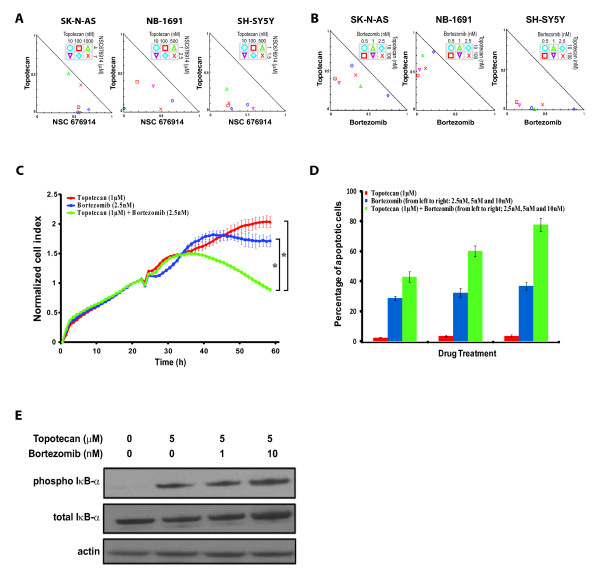
NF-κB pathway inhibitors potentiated topotecan-induced growth inhibition and caspase-3 activation in neuroblastoma cells. (A) Synergistic growth inhibition effect of topotecan and NSC 676914 in combination in three neuroblastoma cell lines (combination index <1). Sub-IC50 drug doses are used in combination and cell growth is plotted in the normalized isobolograms. (B) Normalized isobolograms showed synergy in growth inhibition by the combination of topotecan and bortezomib in three neuroblastoma cell lines. Shown is representative of three independent experiments. (C) Synergistic inhibitory effect of topotecan (1 μM) and bortezomib (2.5 nM) on cell proliferation in SK-N-AS cells using a real-time cell electronic sensing system (*P = 0.00005). (D) Increased percentage of apoptotic SK-N-AS cells measured by caspase-3 activation with the drug combinations comparing to single drug. (E) Immunoblots showed inactivation of the NF-κB pathway by treating cells with bortezomib through inhibition of degradation of total IκB-α protein